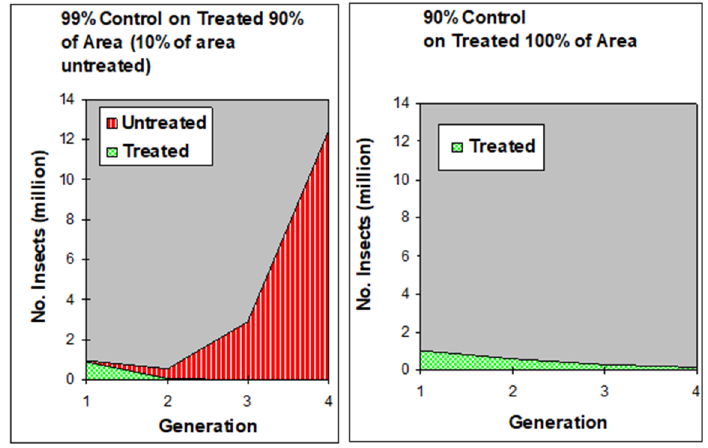
Figure 1. Results of a model that shows the outcome of neglecting to suppress a small fraction of a pest population in an agroecosystem versus the effect of uniformly suppressing the entire pest population. Left: 10% of the population is untreated, and in four generations it produces a large number of individuals, while the 90% of the population that is treated declines. Right: Entire pest population in the agroecosystem is suppressed uniformly, and its numbers decline from generation to generation (Figure from Klassen and Vreysen, 2021, reproduced with permission).